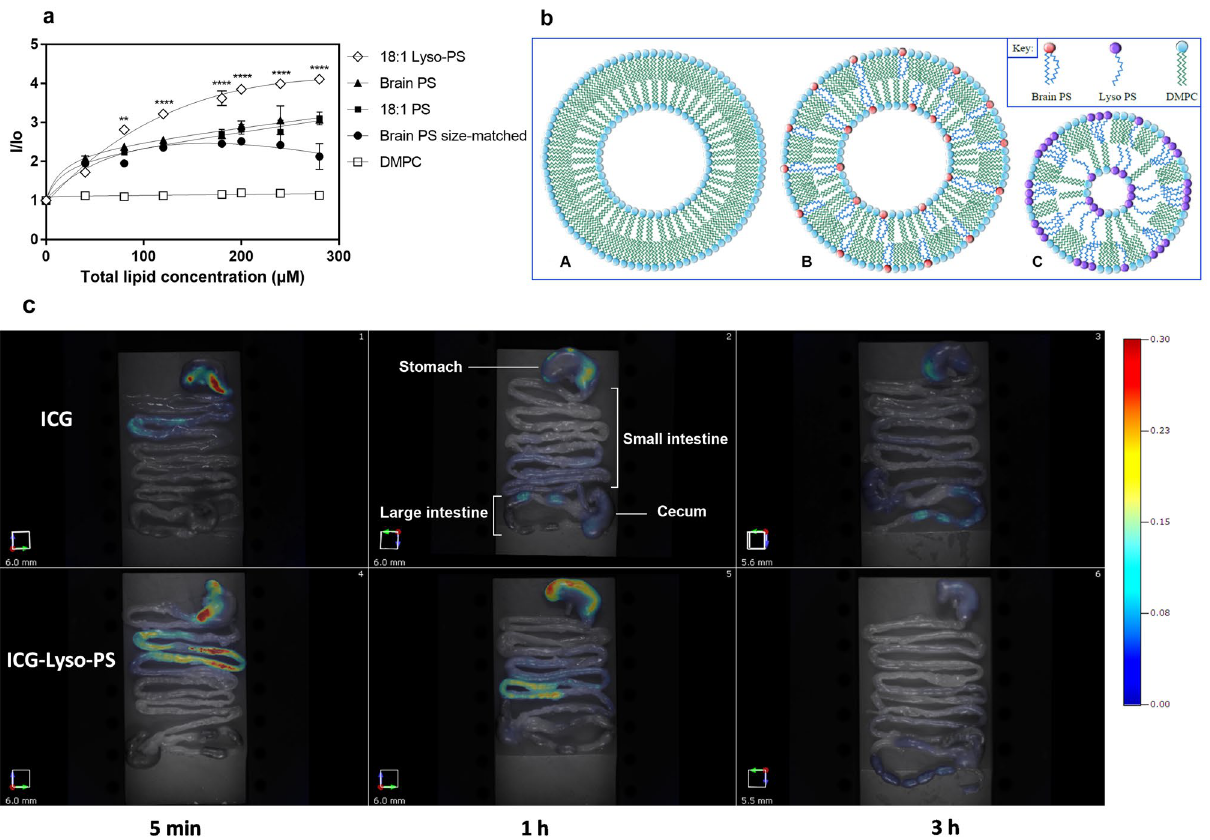
Figure 1. Biophysical characteristics of lipid nanoparticles for immunotherapy. ( a ) Surface exposure of different PS species on the nanoparticles as detected by PSVue fluorescence signal. Changes in fluorescence intensity I/ I 0 were monitored as a function of total lipid concentration and fitted in GraphPad Prism using a single site- total binding model with nonlinear least squares fitting. Data are represented as mean ± SD. Two-way ANOVA followed by Tukey’s post-hoc analysis was performed to detect statistical significance, * P < 0.05. ( b ) Proposed schematic molecular arrangement of Lyso-PS nanoparticles (C) compared to DMPC (A) and PS